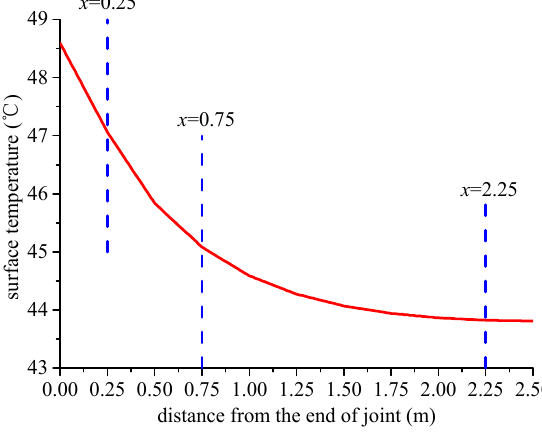
Figure 8. Schematic diagram of cable surface temperature in different measuring spots.